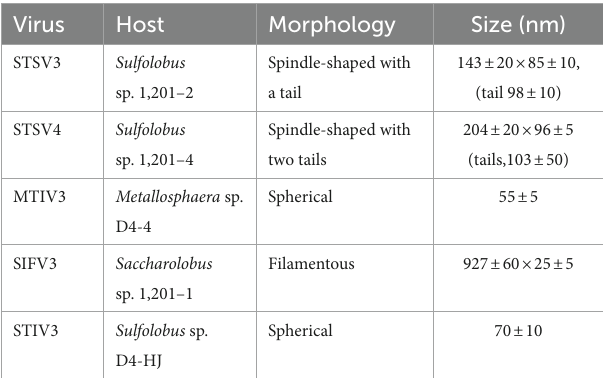
FIGURE 2 Transmission electron micrographs of the VLPs observed in enrichment cultures. (A) filamentous VLPs (870 ± 10 × 25 ± 2 nm); (B) short rod-shaped VLPs (220 ± 10 × 45 ± 5 nm, probably structural variants of spindle-shaped viruses); (C) thin rod-shaped VLPs (920 ± 20 × 20 ± 5 nm). (D) rod-shaped VLPs (750 ± 50 × 25 ± 2 nm); (E) spherical VLPs (50 ± 10 nm); (F) spherical enveloped VLPs (100 ± 90 nm, probably membrane vesicles); (G) spindle-shaped VLPs TABLE 1 The virus-host pairs in the